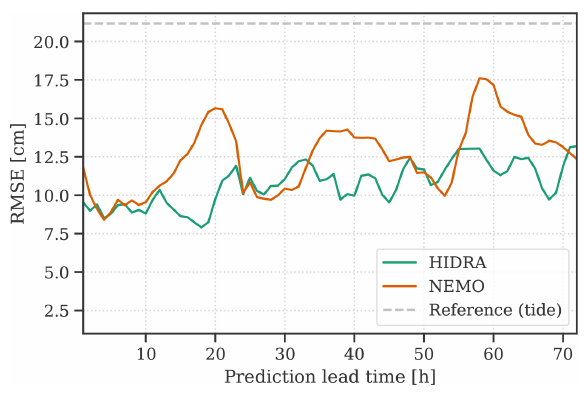
Figure 8. Performance comparison of HIDRA and NEMO with re- spect to the prediction lead time. Error of the astronomic tide is presented for reference as a grey dashed